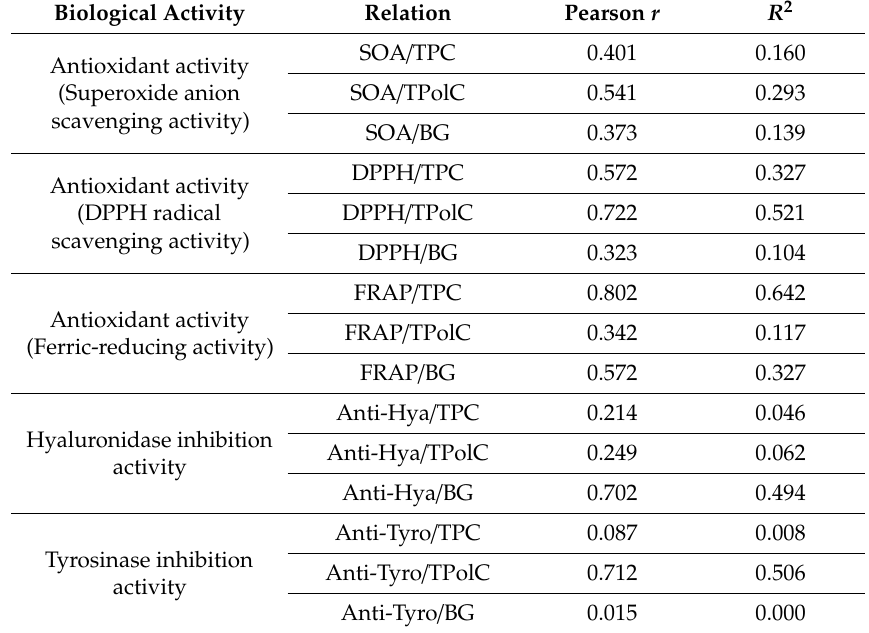
Figure 3. Superoxide anion scavenging activity of extracts from multiple types of mushroom. The values with the same letter in each category are not significantly di ff erent at p > 0.05 by one-way ANOVA. The correlation coe ffi cients of the content of di ff erent components of mushroom extracts and their respective biological activity are shown in Table 3.